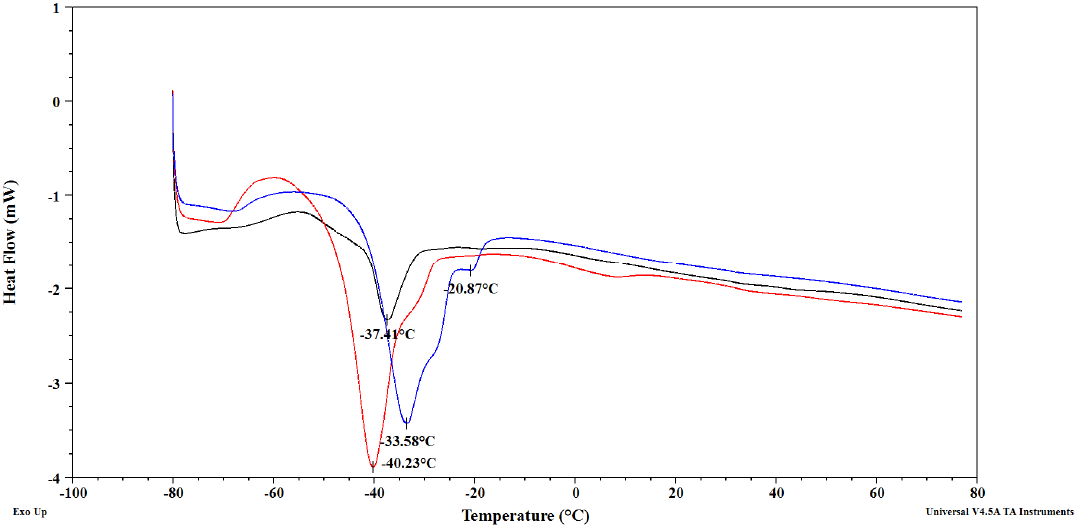
Figure 4. Melting curves of cranberry (blue), black currant (black) and strawberry (red) seed oils.